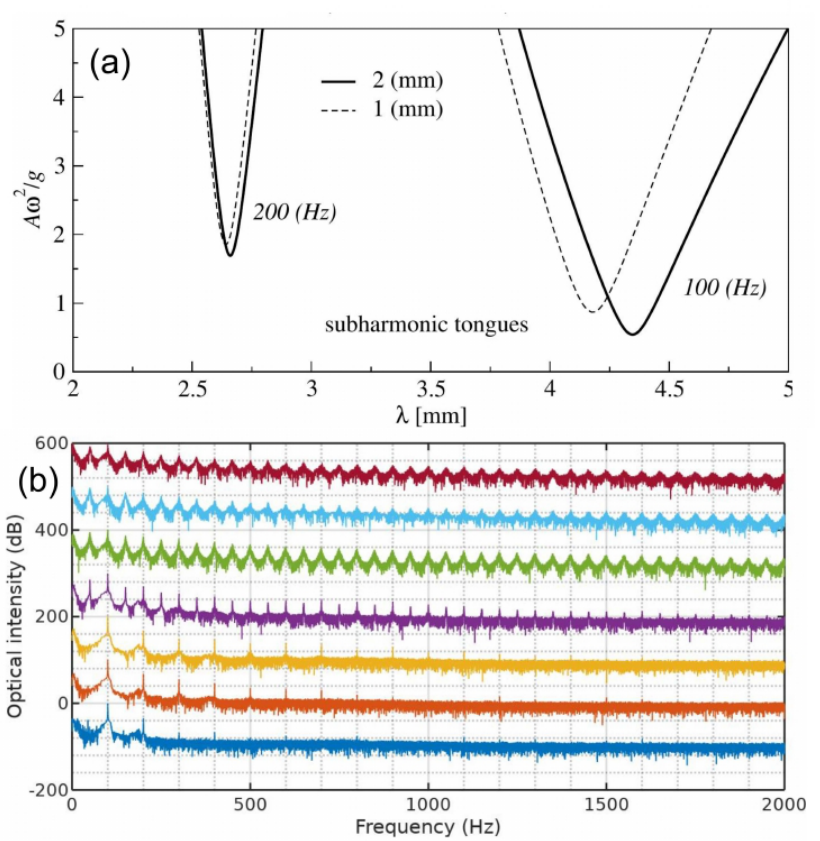
Figure 18. ( a ) Stability diagram for the h = 2mm and h = 1mm deep ethanol layers showing two subharmonic Faraday tongues. The oscillation wave frequency is f F = 50Hz, half of the vertical vibration frequency f = 100Hz. ( b ) Experimental optical spectra for seven gradually increasing (from bottom to top) amplitudes of the vibration signal with f = 100Hz. The depth of the ethanol layer is h = 2mm. All spectra are vertically offset by 100dB. The three lowest spectra are dominated by the vibration frequency f = 100Hz and its higher-order harmonics nf ( n = 2,3, . . . ) that appear due to nonlinear acoustic effects in ethanol. The fourth and so on spectra are dominated by the Faraday wave at f F = 50Hz and its higher-order harmonics. Note that all peaks have a characteristic triangular shape (see the main text). The equal spacing between them allows using the spectra as AFCs. Reproduced from [24] with permission of SPIE and the authors of the